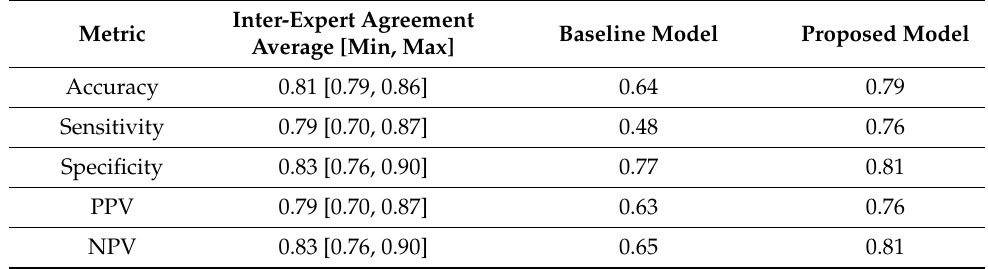
Table 5. Metrics on the secondary dataset for the baseline and the proposed model. The proposed model consistently outperforms the baseline and has metric values close to inter-expert